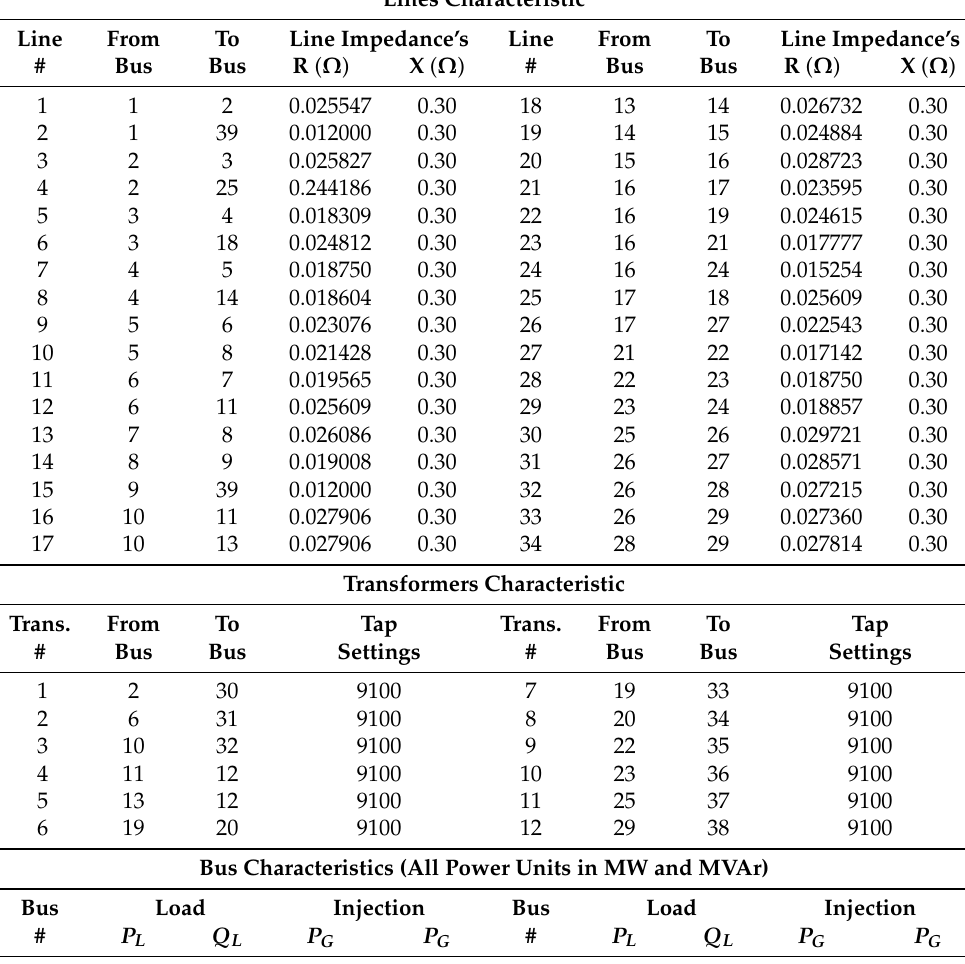
Table 6. Parameters of the IEEE 39-bus test system.